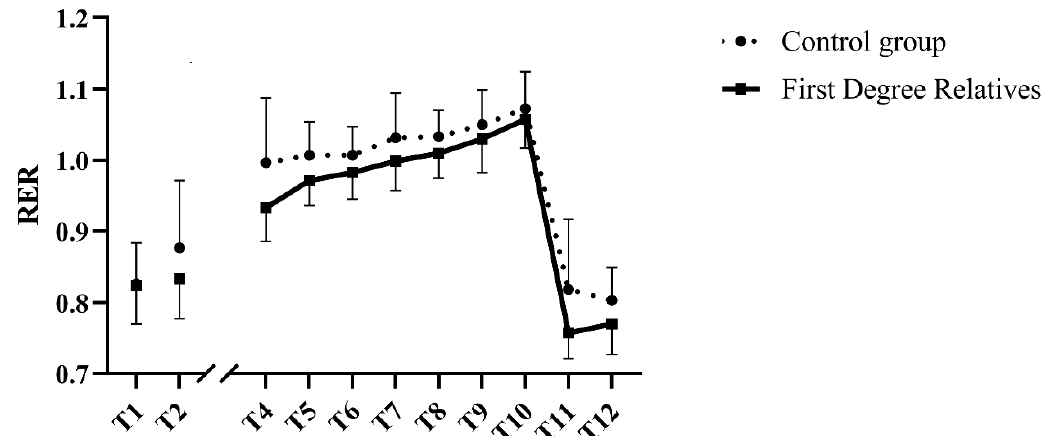
Figure 3. Respiratory exchange ratio before, during and after submaximal exercise in aging women with or without family history of type 2 diabetes. T1 corresponds with resting values taken on the first visit. Data include participants who have not completed the seven stages of exercise. Their data are included up until the last stage of exercise they finished (stage 3, n = 2; stage 4, n = 1, stage 5, n = 2) and resume at T11. AUC = Area under the curve. Data shown as mean ± SD.